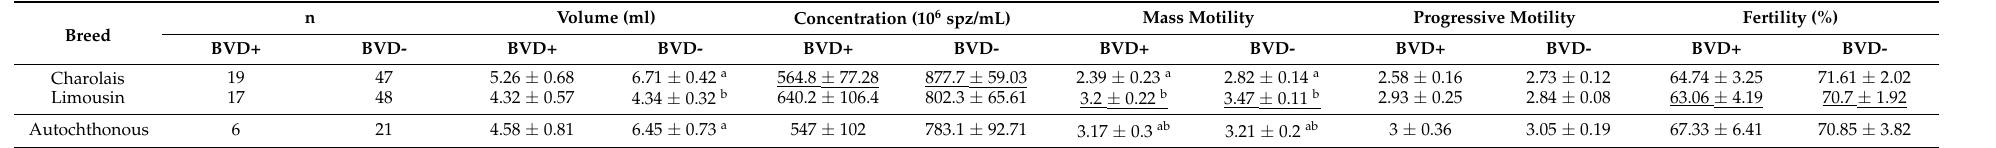
Table 1. Differences in sperm parameters and fertility between BVD-positive and -negative Charolais, Limousin, and autochthonous bulls.